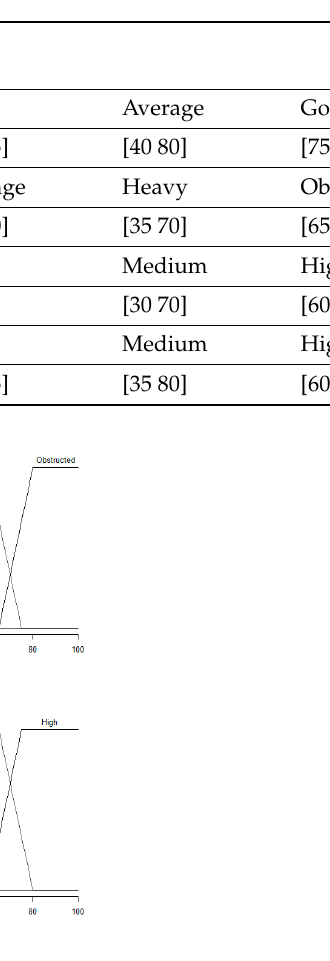
Table 2. List of fuzzy variables and values.